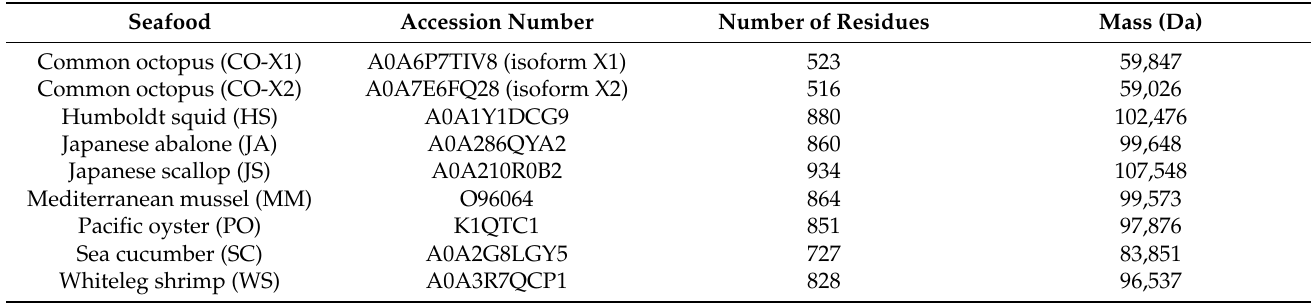
Table 1. Length and molecular masses of paramyosin proteins of eight seafood